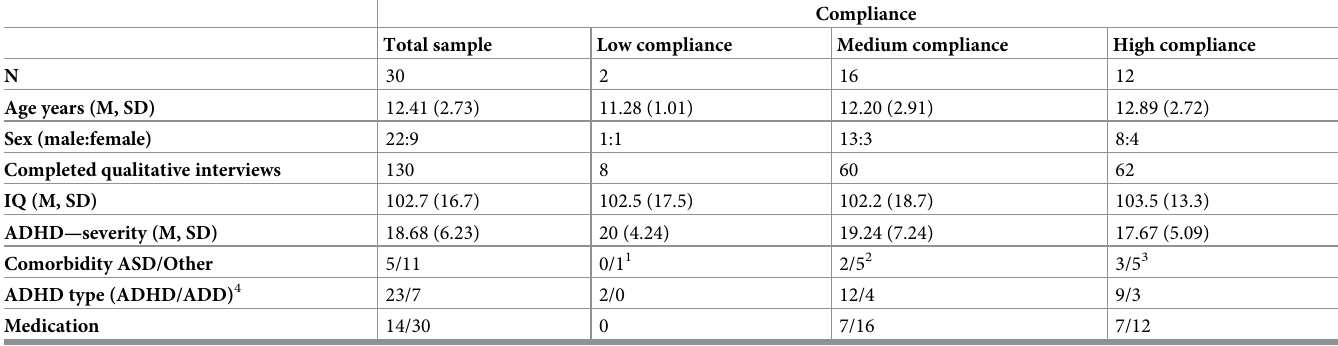
Table 1. Sample characteristics for the total sample and compliance subgroups.